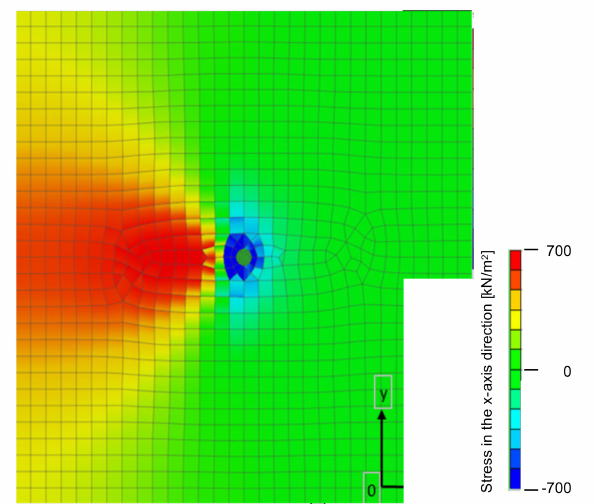
Figure 8. Displacements in x -axis direction as a result of Case-3, as well as when assuming that the new pile was installed straight, without deformation.